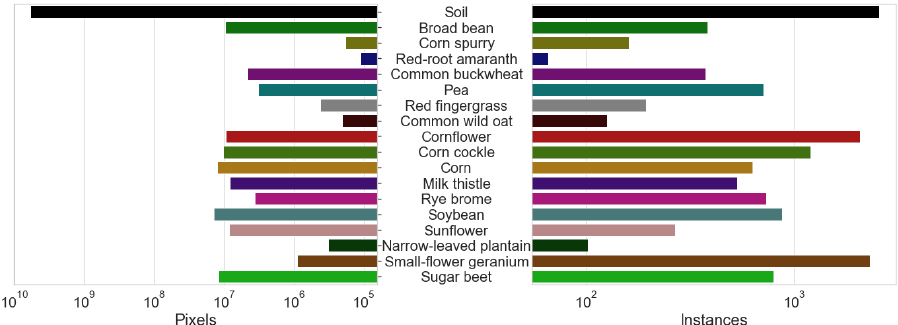
Figure 4. Distribution of labeled pixels ( left ) and instances ( right ) per class for the WE3DS dataset. Both data are shown on a log scale. Instances are the total number of polygons created in the annotation pro- cess. No background instances were created during annotation, we assume one instance of background (not annotated area) per